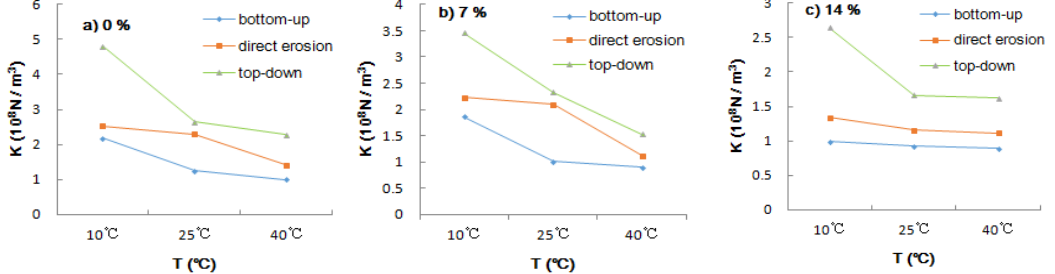
Figure 7. Effect of temperature on interlaminar shear modulus: ( a ) 0%; ( b ) 7%; ( c ) 14%. Figure 7. E ff ect of temperature on interlaminar shear modulus: ( a ) 0%; ( b ) 7%; ( c )